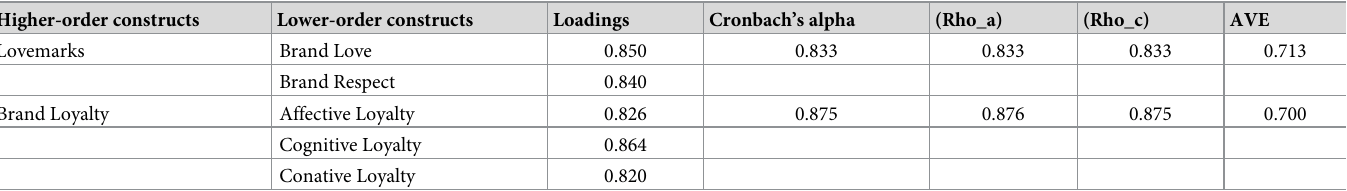
Table 3. Second-order measurement model.